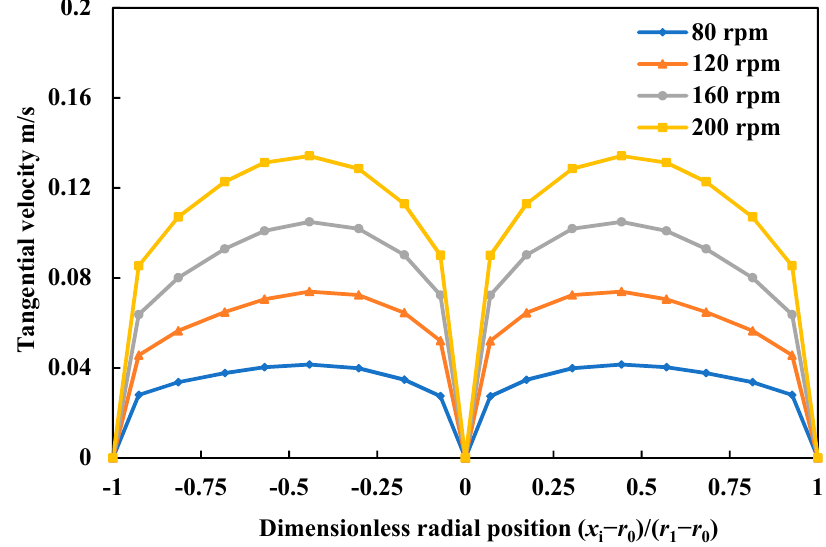
Figure 6. Dimensionless radial profiles of tangential velocity for the straight blade at α = 0° with different rotational speeds at z = 1.0 m cross-section.